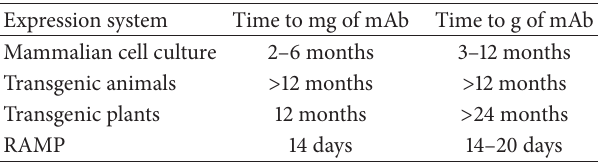
Table 2: Transient plant technology: the advantage of RAMP ∗